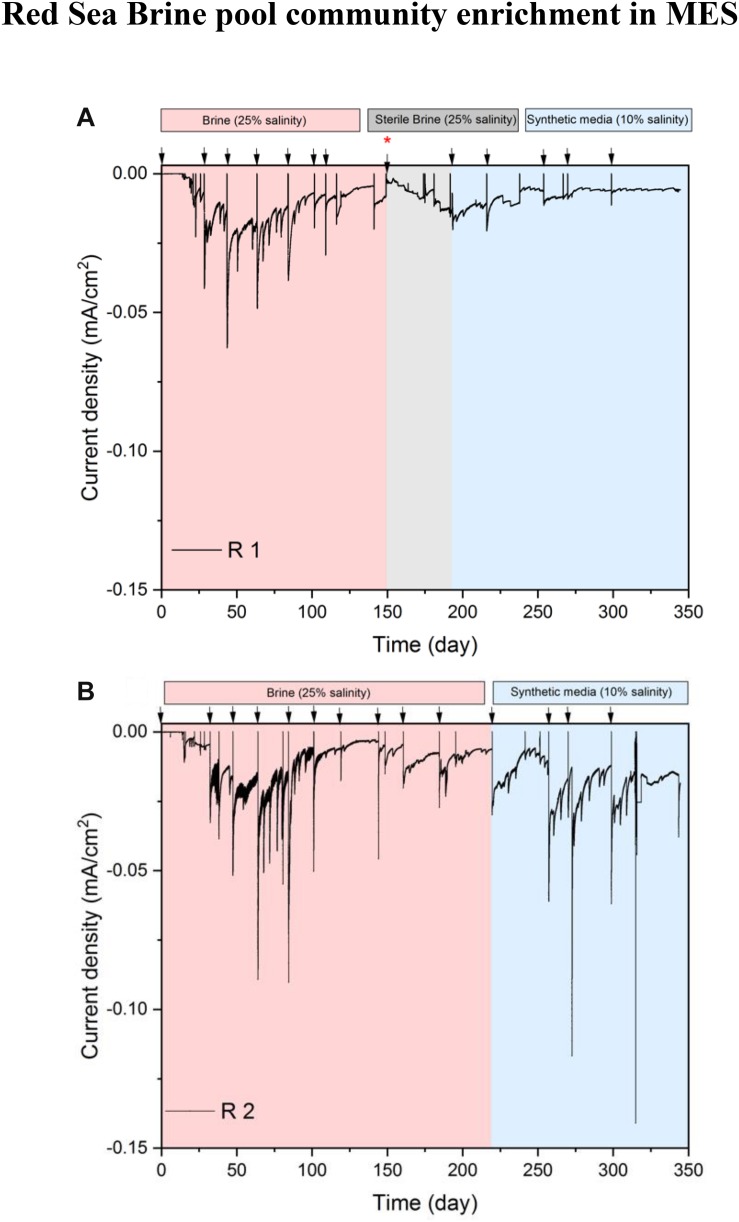
Chronoamperometry profile of phase I. (A) Current density of MES reactor R1, which was subjected to three conditions: brine pool solution (25% salinity), sterilized brine pool solution (25% salinity) and synthetic saline media (10% salinity). (B) Current density of MES reactor R2, which was subjected to two conditions: brine pool solution (25% salinity) and synthetic saline media (10% salinity). Arrows indicate the time of batch change. The red asterisk on day 150 indicates when biocathode from R1 was transferred to a new MES reactor containing sterile brine pool solution (25% salinity) and a piece of biocathode from R1 was introduced into a serum vial (see Figure 1) containing synthetic saline media (10% salinity). Also, a piece of biocathode from R1 was taken on day 150 for SEM.